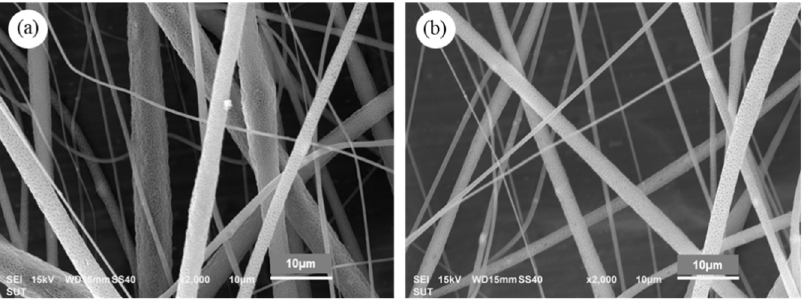
Figure 12. SEM images of PLA/1DP-nHAp ( a ) 25 kV and ( b ) 30 kV.